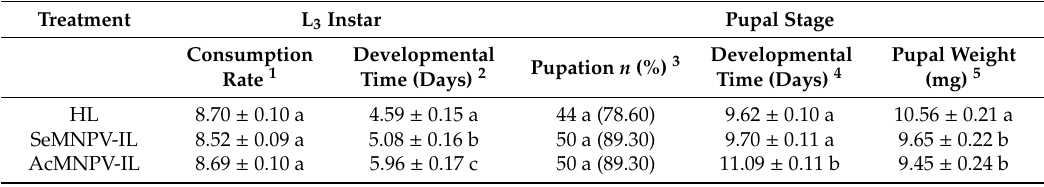
Table 3. Side e ff ects of the baculoviruses of S. exigua (SeMNPV) and Autographa californica (AcMNPV) on the preimaginal parameters of Chrysoperla carnea after the consumption of healthy and LC 95 -infected L 2 Spodoptera exigua larvae.